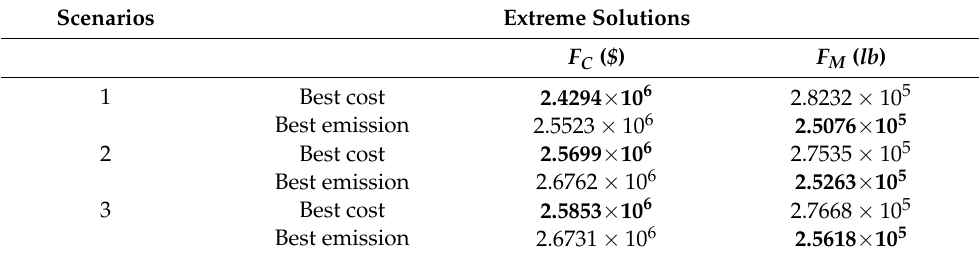
Table 8. The extreme solutions of different scenarios.